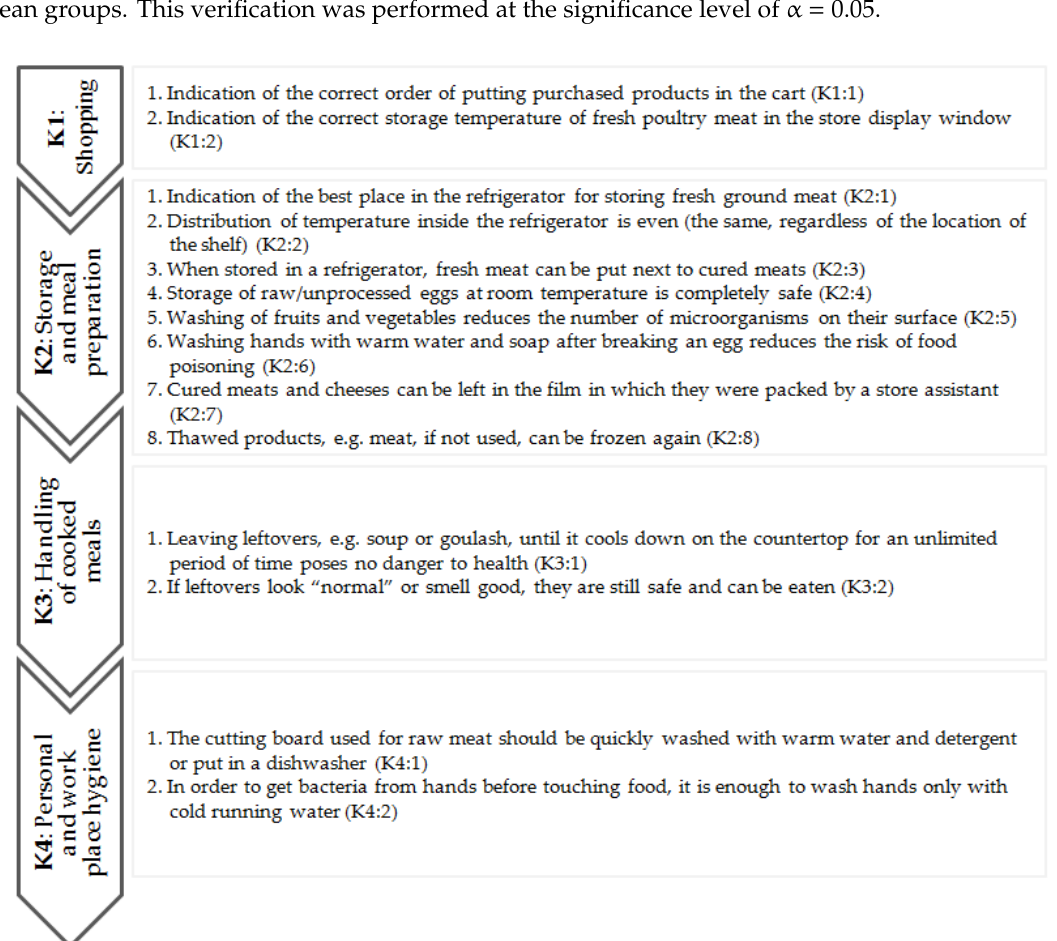
Figure 2. Arrangement and designation of issues covered by the consumer knowledge part of the questionnaire (K).